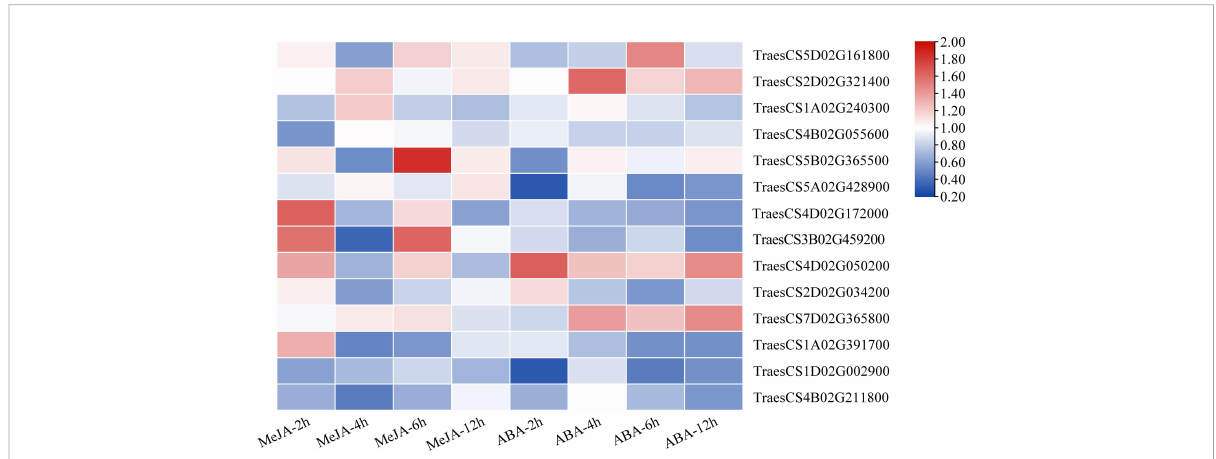
FIGURE 5 Relative expression analysis of 14 representative TaRR-RLKs from each subfamily in wheat leaves under MeJA and ABA treatment. Data shown are the means of three biological replicates ± the SE. The values were normalized to those for the reference gene (Cell Division Control protein, TaCDC ) and are presented as fold changes in expression relative to that in wheat leaves without treatment. The mean expression values were visualized by Tbtools. The color scale represents expression values of each sample. The blue box represents the lower levels and the red box represent high levels of expression level. The qRT-PCR values used for the heat map are listed in Supplementary Table